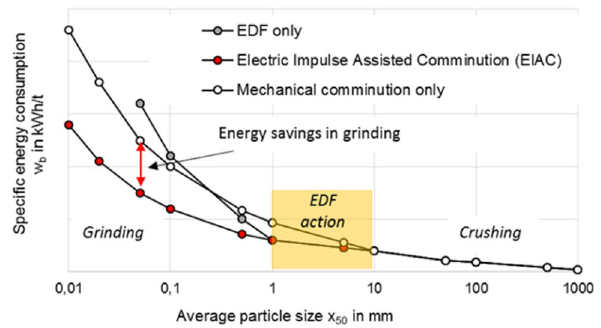
Fig. 4 Schematic diagram showing the energy demand for conven- tional comminution and with Electrodynamic Fragmentation